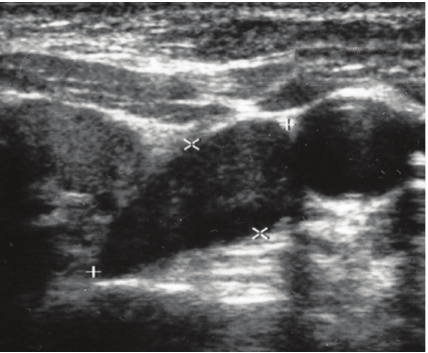
Figure 4: Ultrasound finding of parathyroid carcinoma (trans- verse)—nonsuspicious “Pad” at the lower pole of the left thyroid lobe.